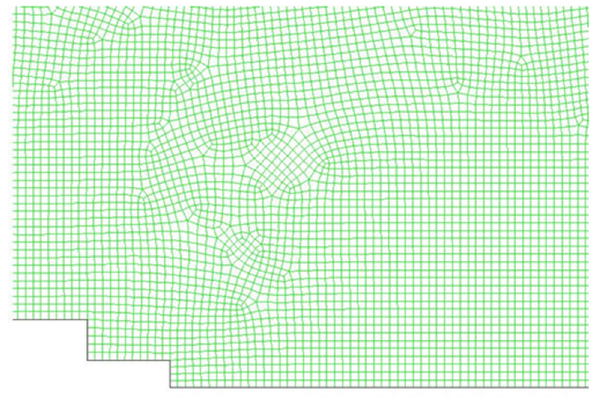
Fig. 4 An example of gridding and grid size distribution (0.0085 m)